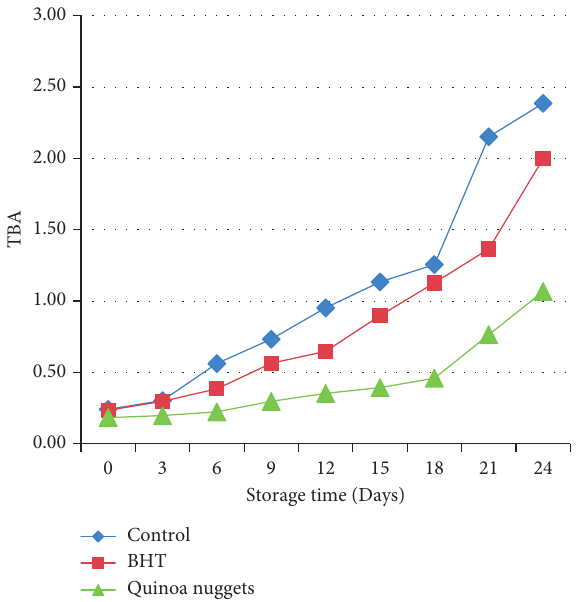
Figure 1: Lipid oxidation (TBARS) (mg MDA/kg) of chicken nugget samples during storage at 4 ° C for 24 days.